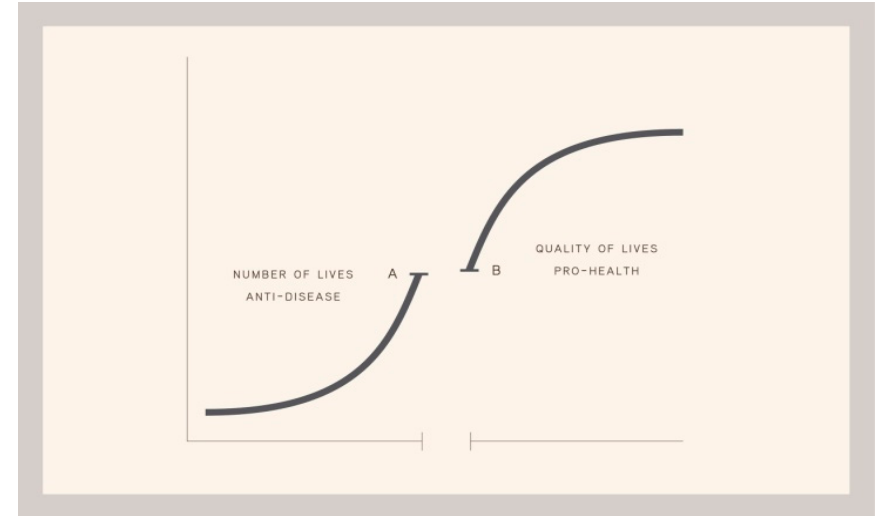
Figure 5. The shifting focus of values from ‘fighting disease’ to ‘promoting health’ with transition from population expansion to plateau in both population growth and the availability of resources.